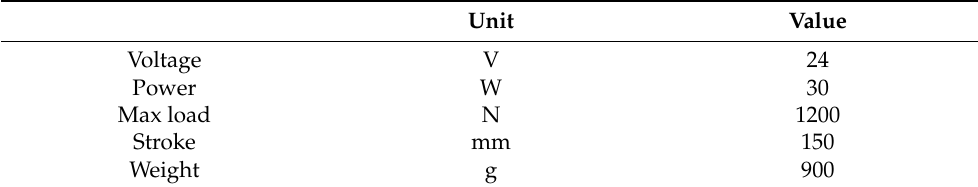
Figure 4. Exploded view of pulley position conversion system .